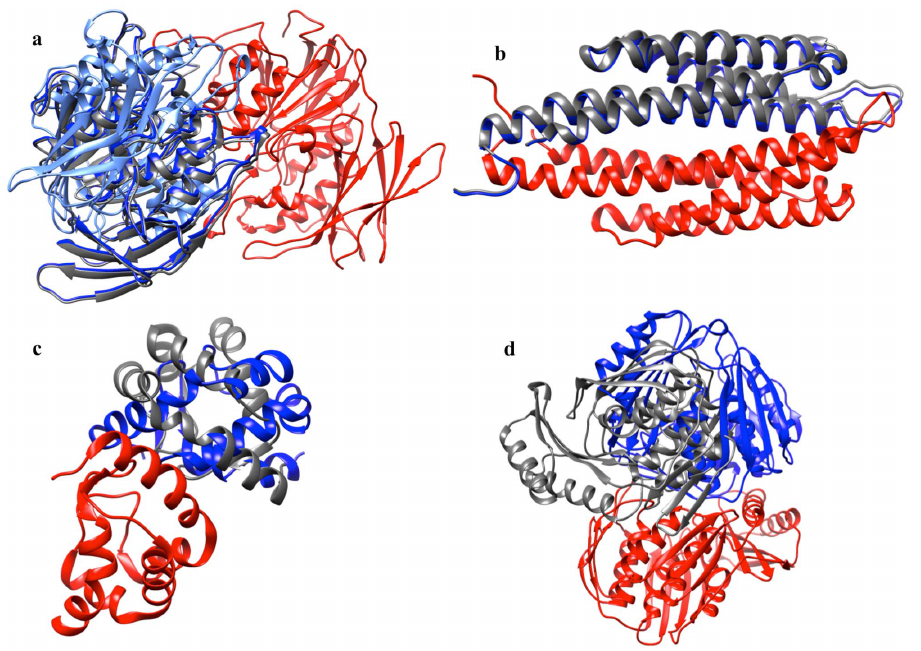
Figure 2. DockScore performance on testing dataset. 15 heterodimers and 15 homodimers were used for testing the performance of the scoring scheme. DockScore assigned the top-most rank in 26 of the cases. The four cases where, non-native pose was assigned a higher score than the native pose were analysed by structural superposition, (a) 2QFR, (b) 2LIG, (c) 2AIB and (d) 1QMH. One of the chain of all poses, including the native, is colored red, native pose of the other chain in grey and the non-native poses which were ranked higher are shown in blue colour. These poses were observed to be structurally very similar to native pose.